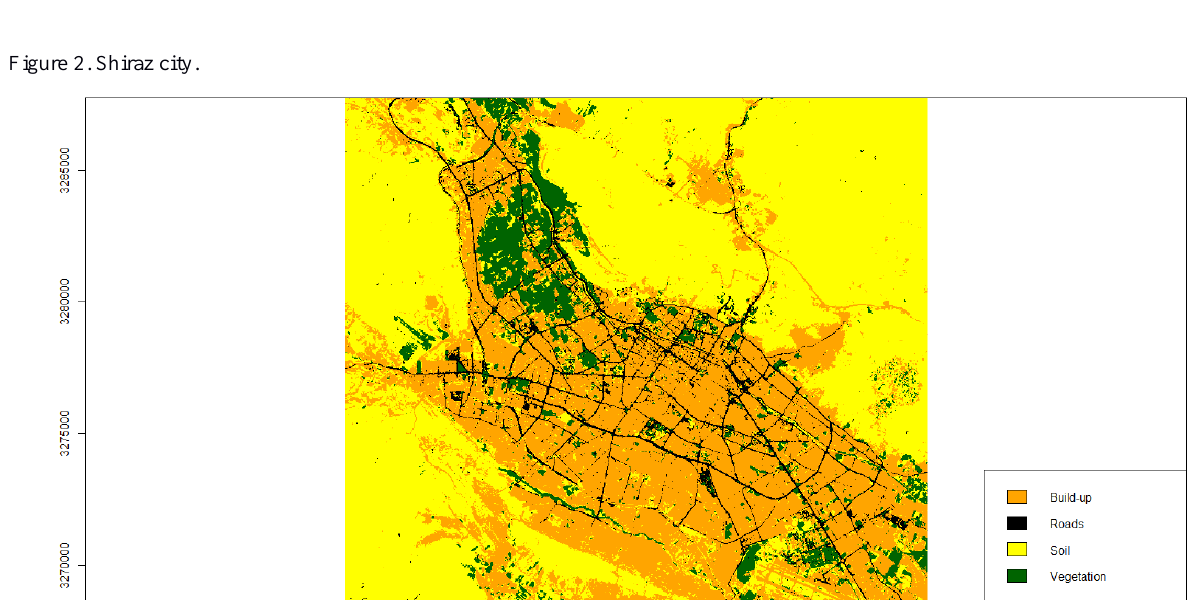
Figure 2. Shiraz city.